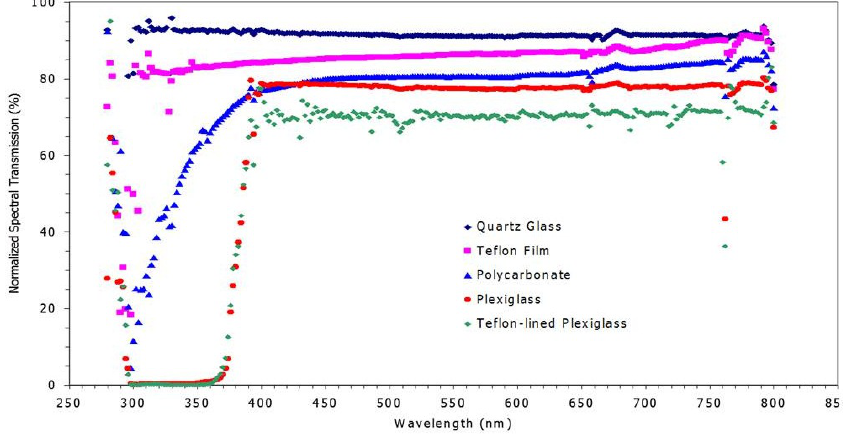
Fig. 2. Spectroradiograph measurements of materials commonly used for flux chamber